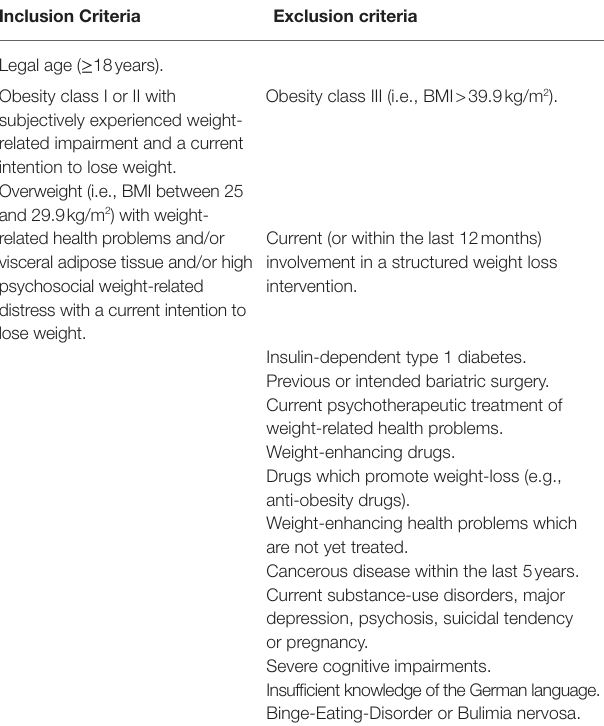
TABLE 1 | Eligibility criteria of the I-GENDO